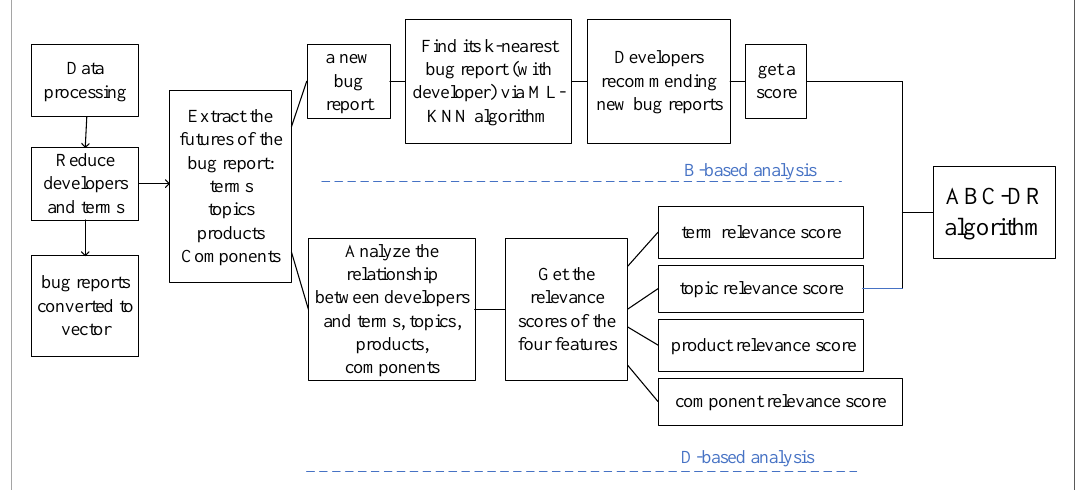
Figure 1. Overall framework of the ABC-DR